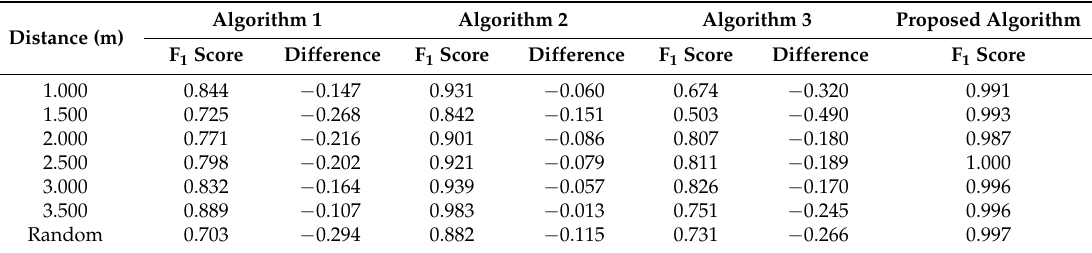
Table 2. F 1 score values for the proposed and benchmark algorithms at different distances.